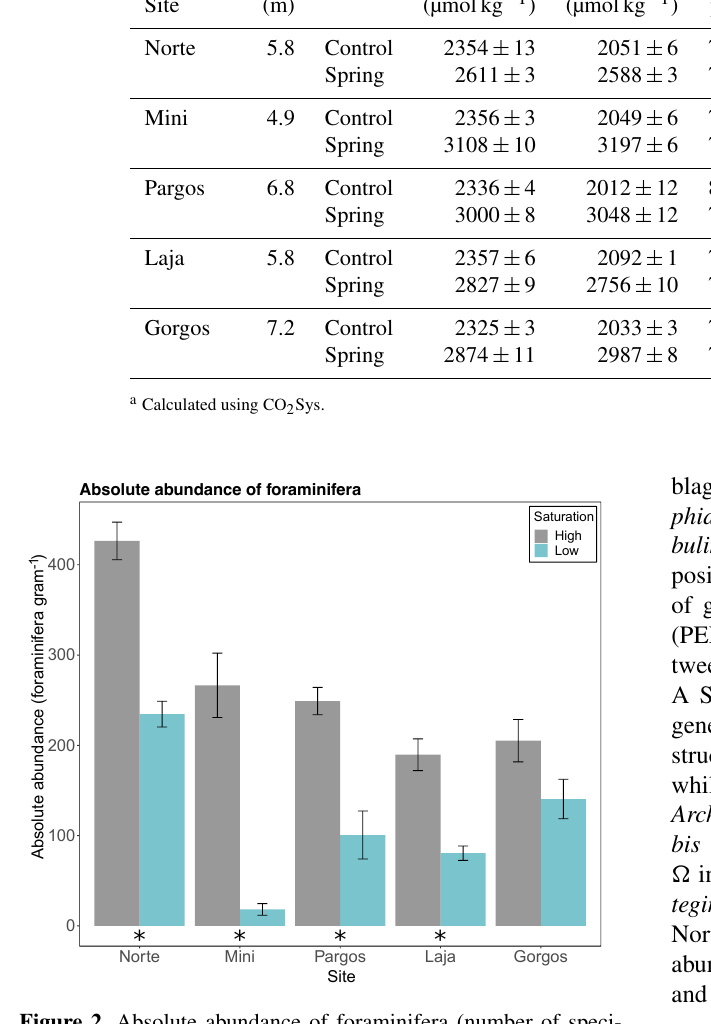
Figure 2. Absolute abundance of foraminifera (number of speci- mens per gram of sediment) in different submarine springs (low- saturation state) and their respective control sites (high-saturation state). Data are represented in mean ± SE ( n = 5). The asterisk demarks a significant difference ( p< 0 . 05) in abundance between paired springs and controls at each site, according to the Mann– Whitney rank sum